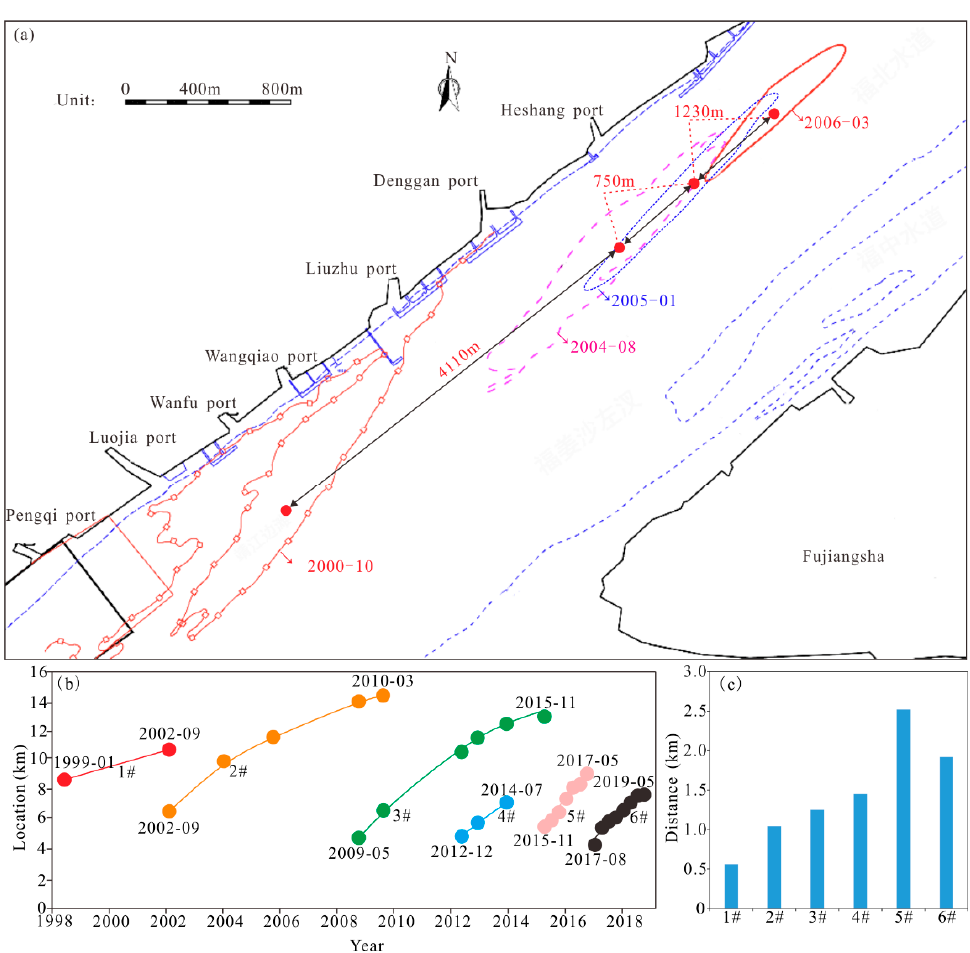
Figure 10. ( a ) Center position of the splitting body of Jingjiang Beach from October 2000 to March 2006. ( b ) Movement tracks of the splitting body, the reference point (0 km) is located at Jiangyin Bridge. ( c ) The longitudinal transport distance of the splitting body of Jingjiang Beach for each cycle.